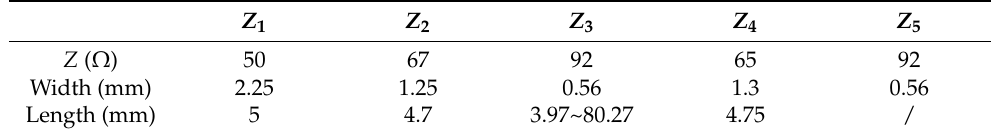
Table 2. Parameters of the upper feeding network.